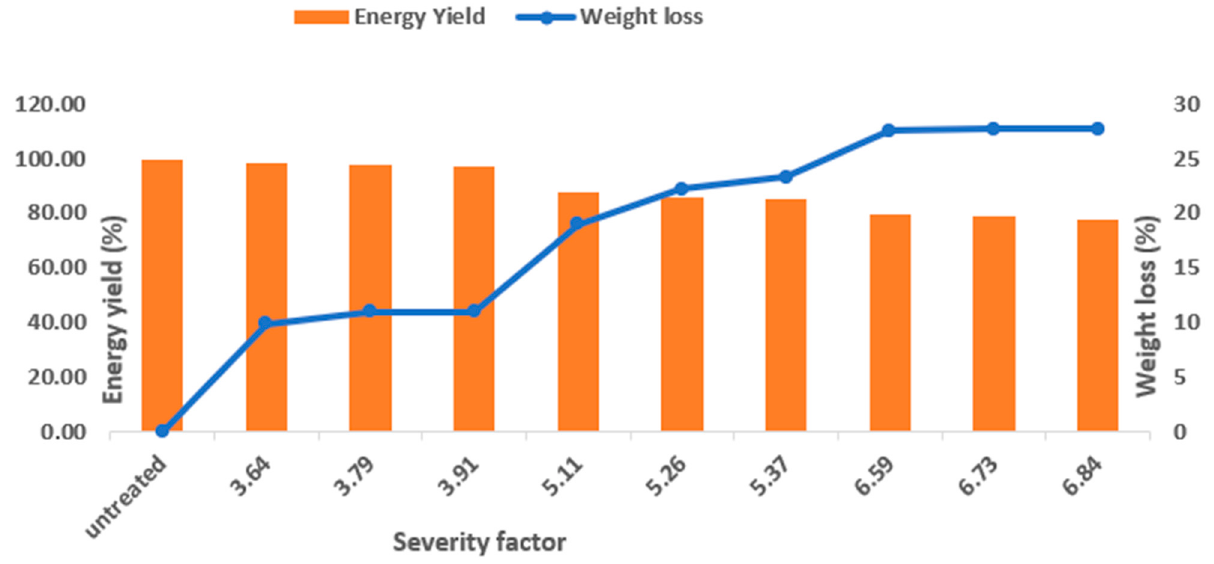
Figure 3. Weight loss and energy yield of WSS at different severity factors.